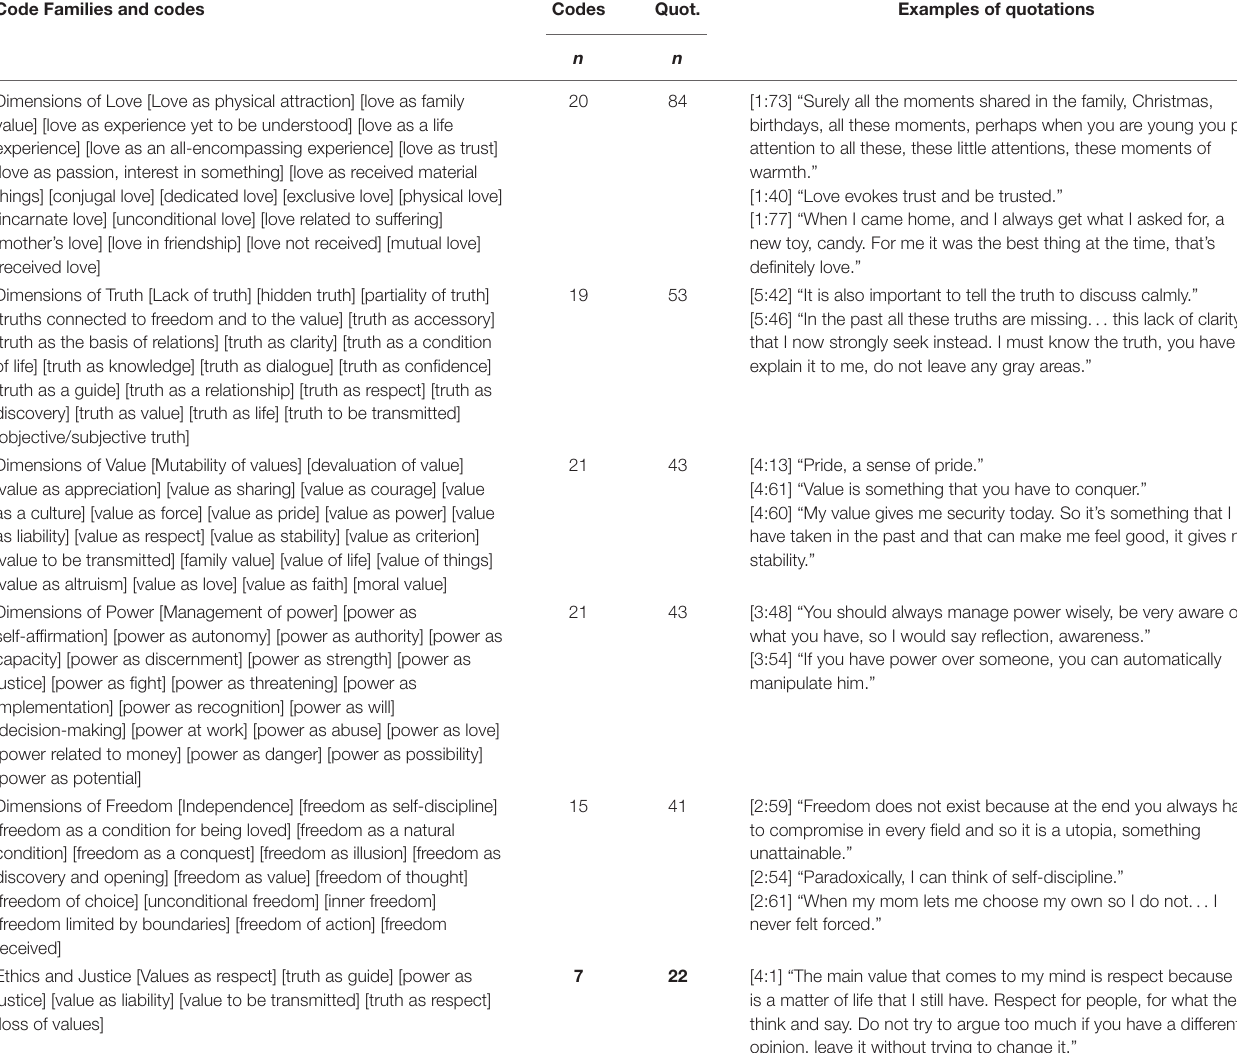
TABLE 1 | Code Families in the first Hermeneutic Unit (HU1): ad hoc Code Families with examples from transcripts. Code Families and codes Codes Quot.